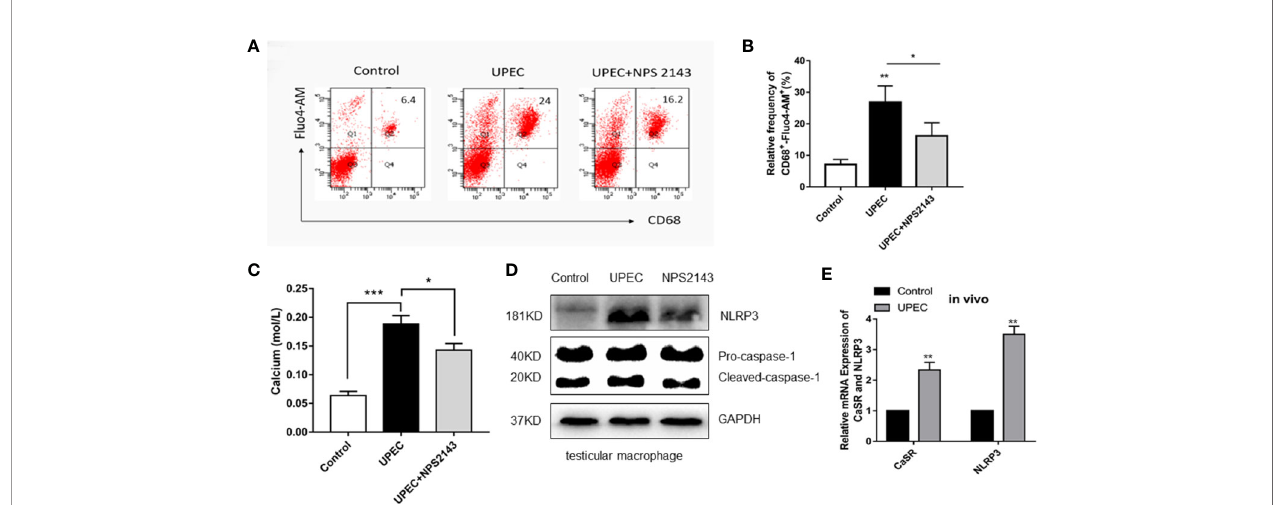
FIGURE 4 | CaSR promotes the recruitment and assembly of NLRP3 in fl ammasomes through Ca 2+ . (A) The level of calcium ion in primary TM of each group was detected by fl ow cytometry ( n =3/group). (B) Statistical analysis was performed on the results of the convection detection of calcium ion levels in the primary TM of each group. (C) The calcium level of each group labeled with the fl uorescent indicator Fluo-am was detected using a microplate reader ( n =3/group). (D) TM were isolated from the testes of rats in the control group and 7 days after UPEC treatment. After the collection of the macrophages, the protein levels of NLRP3 and caspase-1 in the macrophages were analyzed by Western blotting. (E) The expression of CaSR and NLRP3 genes in the two groups was detected ( n =5/group). * P < 0.05, ** P < 0.01, *** P < 0.001 ( t